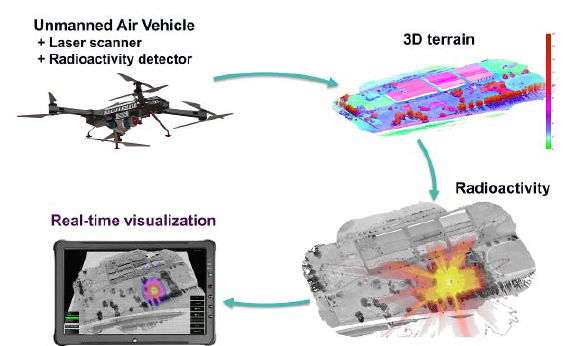
Figure 1: Approach for UAV-based 3D terrain acquisition and radionuclide